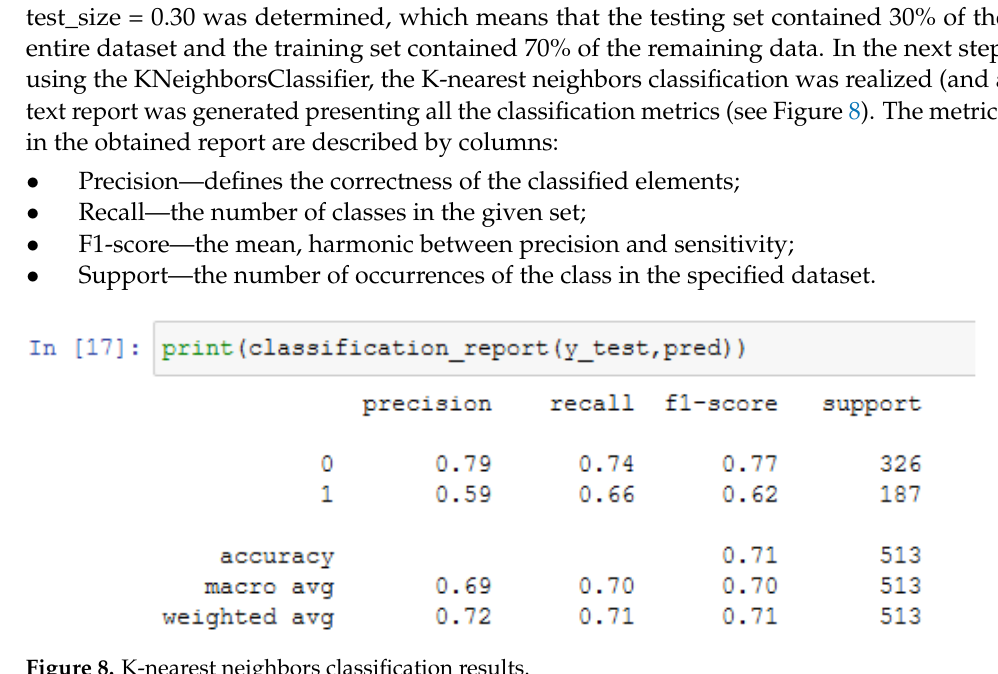
Figure 8. K-nearest neighbors classification results.